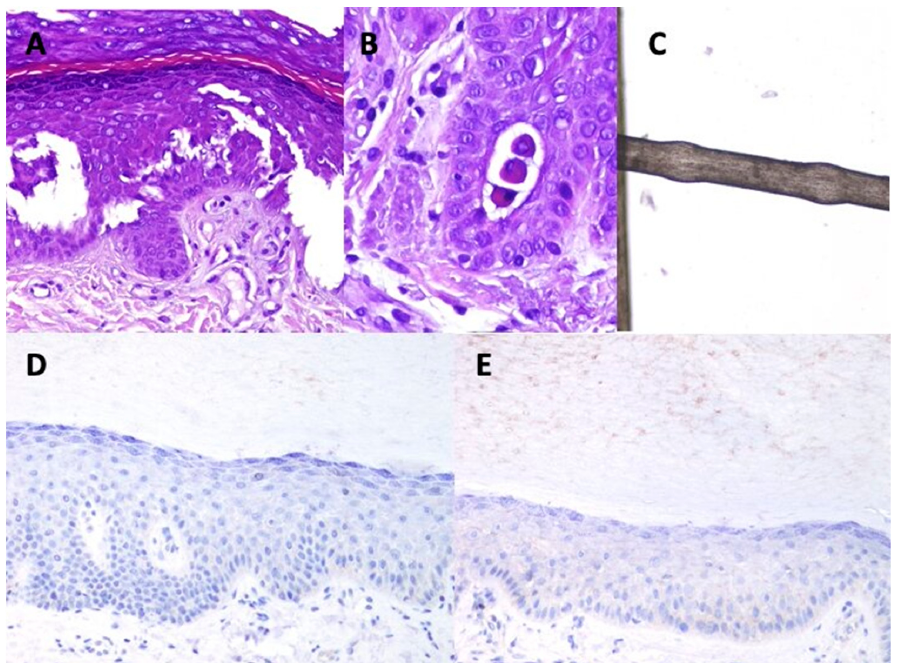
Figure 1. Main findings in the immunohistochemistry study. ( A ): acantholytic areas evidenced in case 9 (Hematoxylin-Eosin ×200). ( B ): Acantholytic round cells. Some desmosomes (spines) are still observed between the round cells and adjacent keratinocytes (hematocillin-eosin ×400). ( C): monilethrix. ( D ): negative expression of desmoplakin in case 4 (×200). ( E ): weak expression of desmoplakin in case 6 (×200).